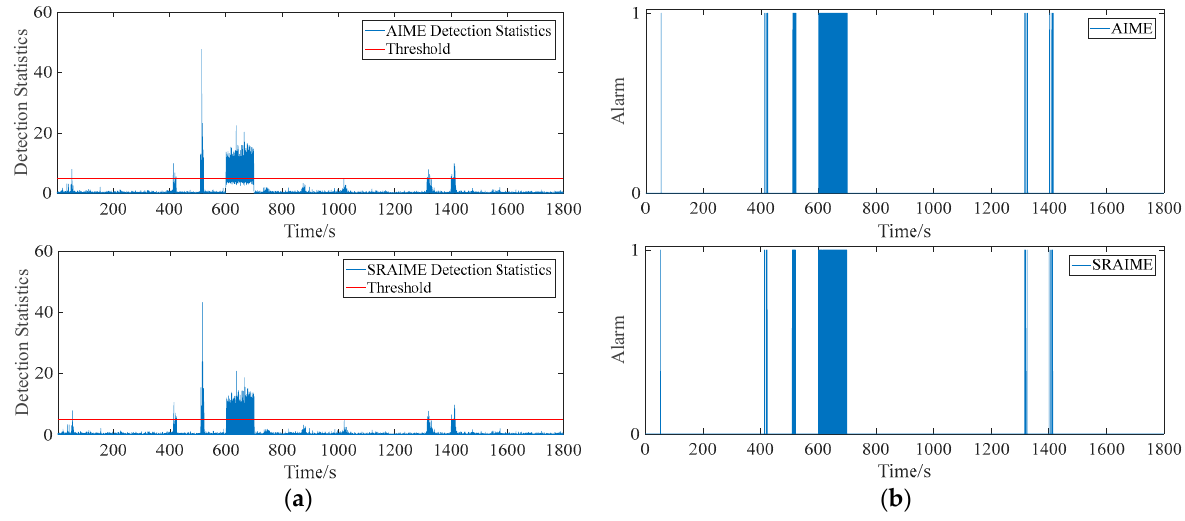
Figure 14. The slowly-growing gross error detection results of Wilford Bridge by GNSS/accelerometer fusion after adding gross errors: ( a ) Detection statistics after adding gross errors; ( b ) Alert situation after adding gross errors. Table 3. Wilford Bridge Statistics of AIME/SRAIME gross error detection results.